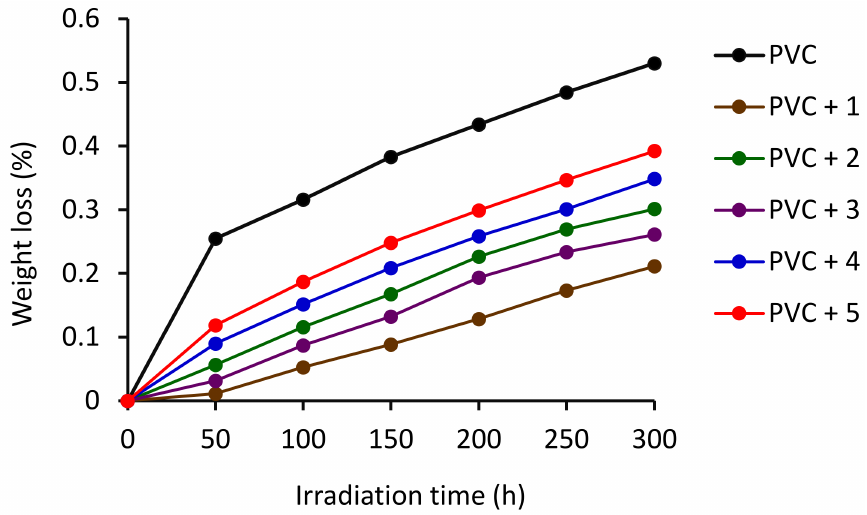
Figure 2. Percentage weight loss of PVC films as a function of irradiation